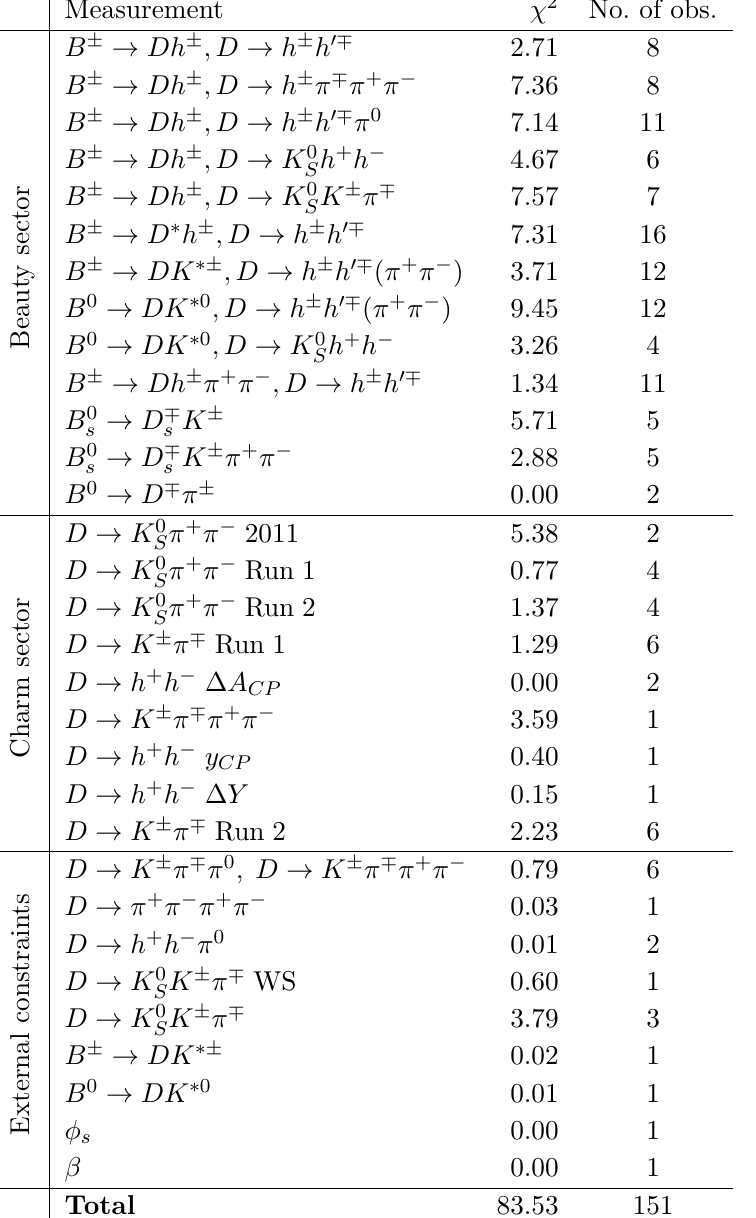
Table 10 . Contributions to the total χ 2 and the number of observables of each input